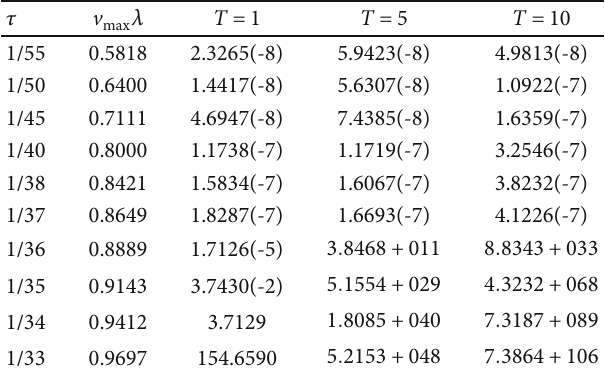
Table 5: The L ∞ norm error with h = 1/32 for di Example 2.